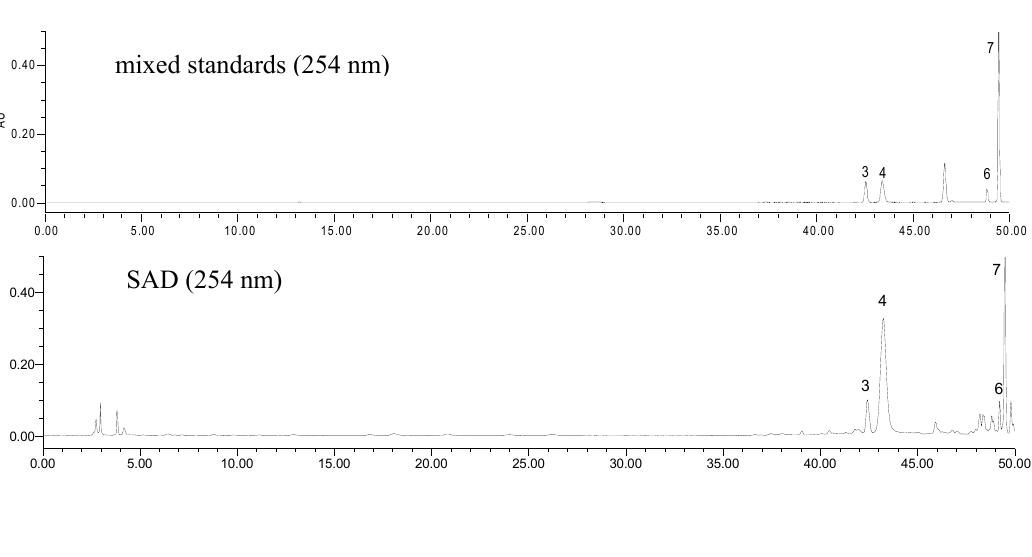
Figure 3. Typical HPLC chromatograms of mixed standards and the investigated samples at 254 nm. ephedrine ( 1 ), amygdalin ( 2 ), liquiritin ( 3 ), benzoic acid ( 4 ), isoliquiritin ( 5 ), formononetin ( 6 ) and glycyrrhizic acid ( 7